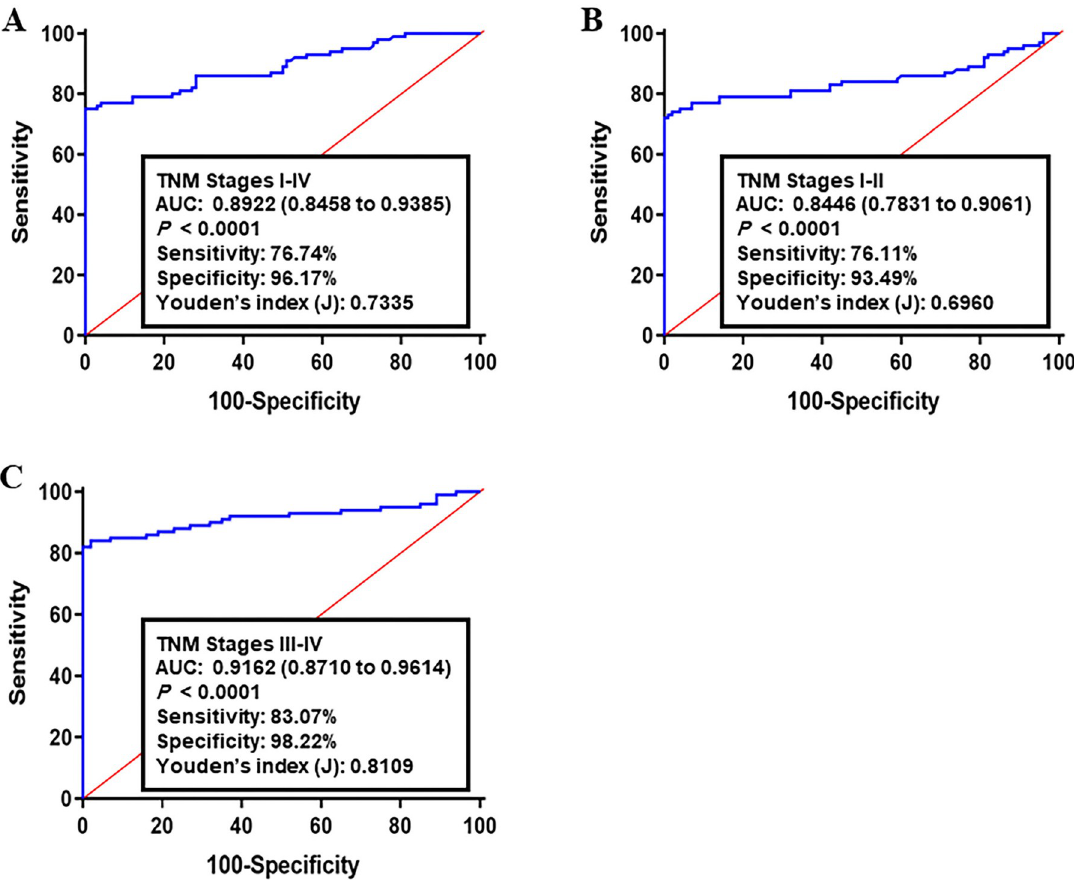
Fig 1. Receiver operating characteristics (ROC) curve analysis of the log it model with the ACOT8/ACSL5/FASN/HMGBCS2/ SCD1 panel in the training set. The study group consisted of 257 CRC tumor specimens and matched adjacent normal tissues. Using the optimal cutoff value as 0.493, the diagnostic performance of gene panel for discriminating (A) All TNM stages, (B) early CRC (I-II TNM stages), and (C) advanced CRC (III-IV TNM stages) from healthy samples was examined. Log it (p) of model was 0.429 + 0.659 x ACOT8 + 0.084 x ACSL5 + 0.029 x FASN + 0.201 x HMGCS2 + 0.119 x